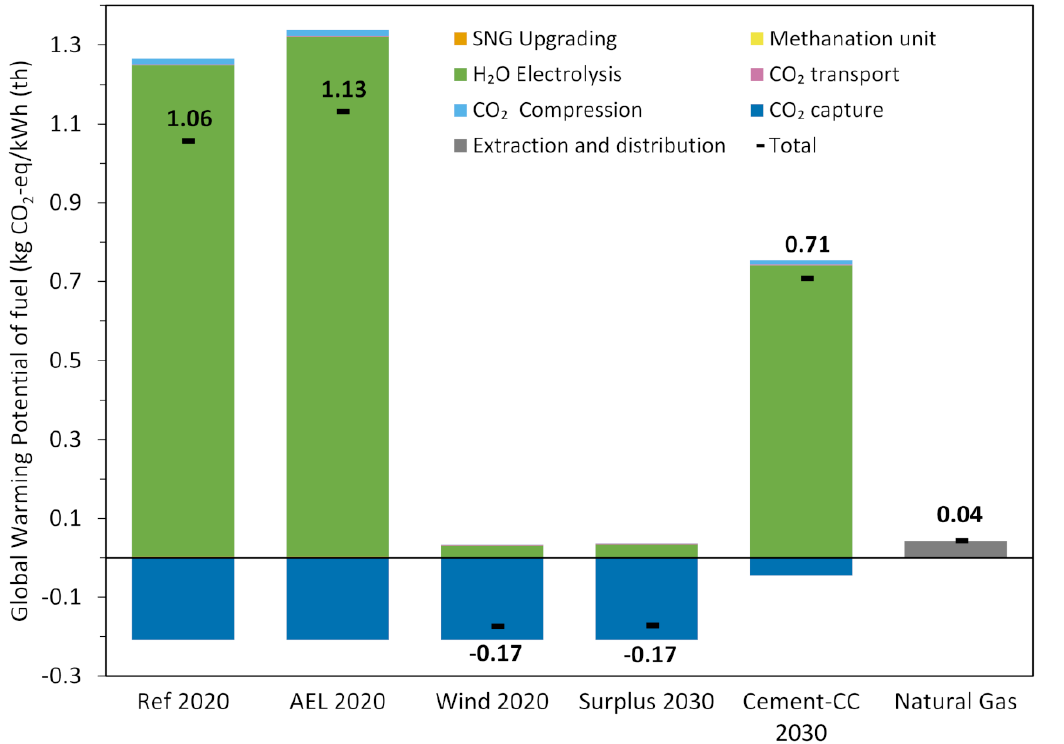
Figure 9. GWP of fuel in conventional and CO 2 -based pathways. Life cycle inventory is stated in the Supplementary Materials Section